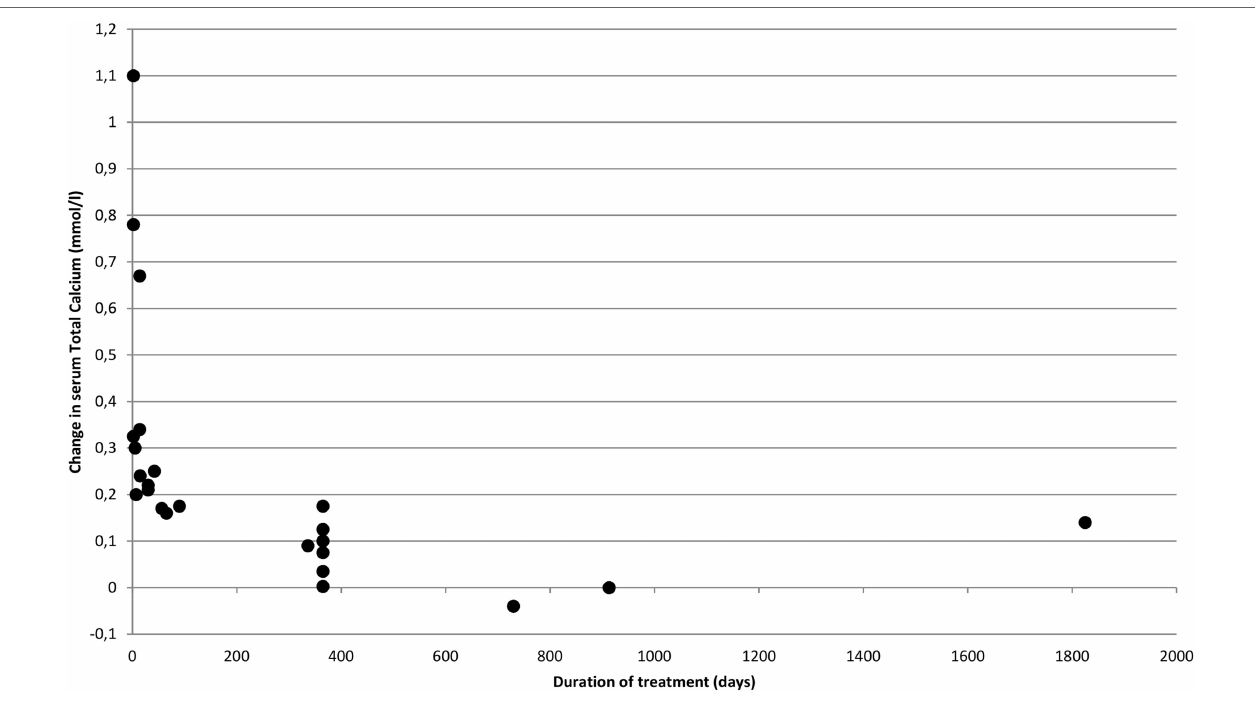
FiGURe 2 | effect of bisphosphonates on s-calcium over time